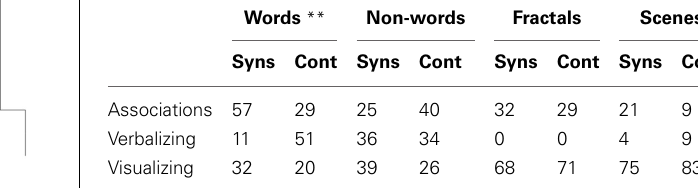
Table 1 | Encoding strategies reported by grapheme-color synaesthetes and controls for the various stimuli during the debriefing questionnaire (%). Words ** Non-words Fractals Scenes Syns Cont Syns Cont Syns Cont Syns Cont Associations